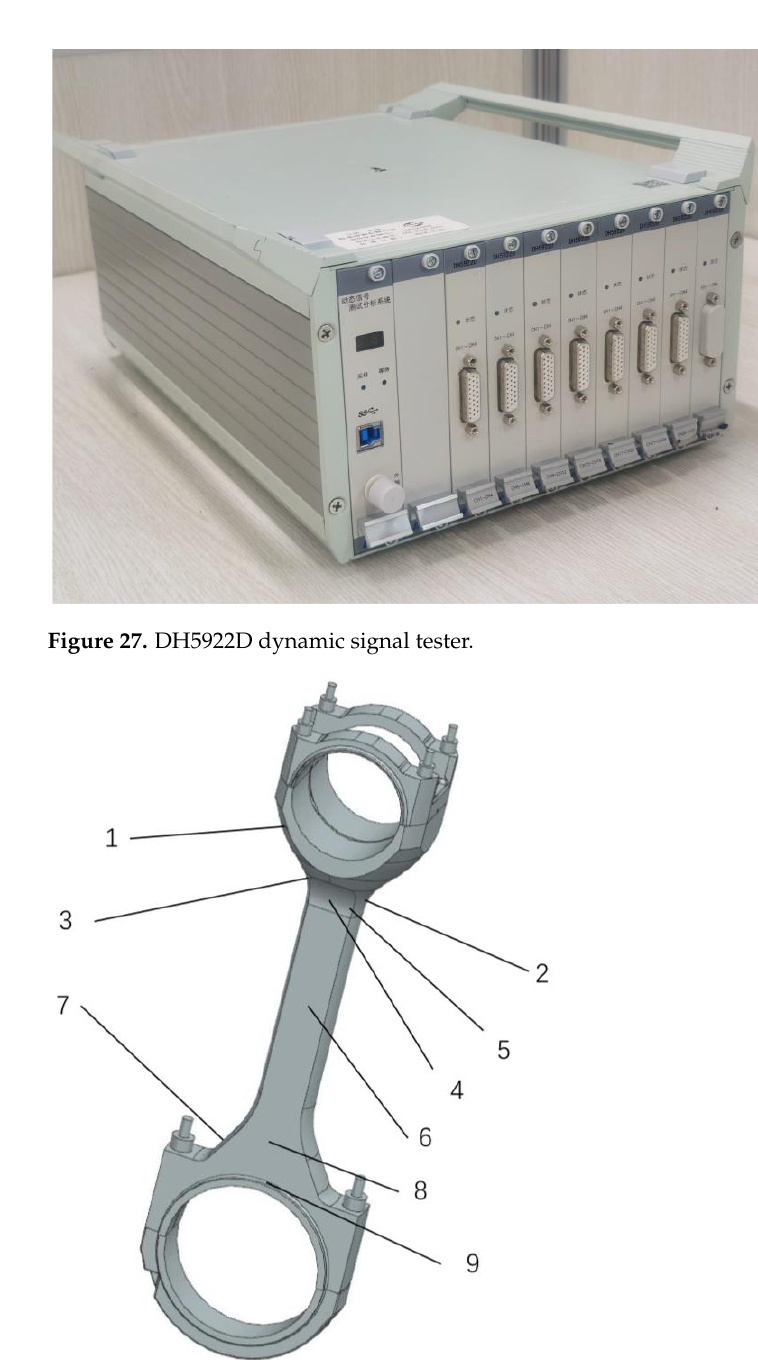
Figure 26. WAW-2000 universal testing machine.